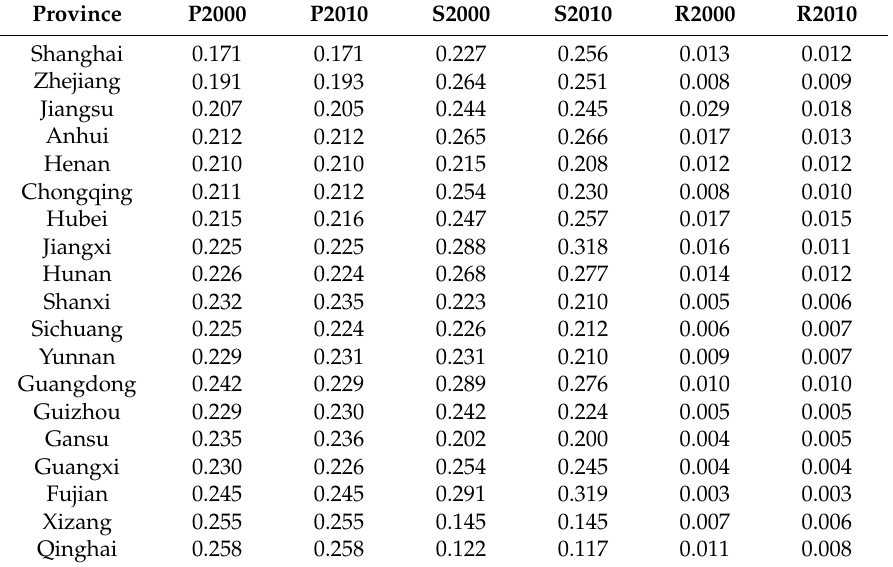
Table 4. The average PSR (pressure-state-response) values in different provinces of the Yangtze River Basin.